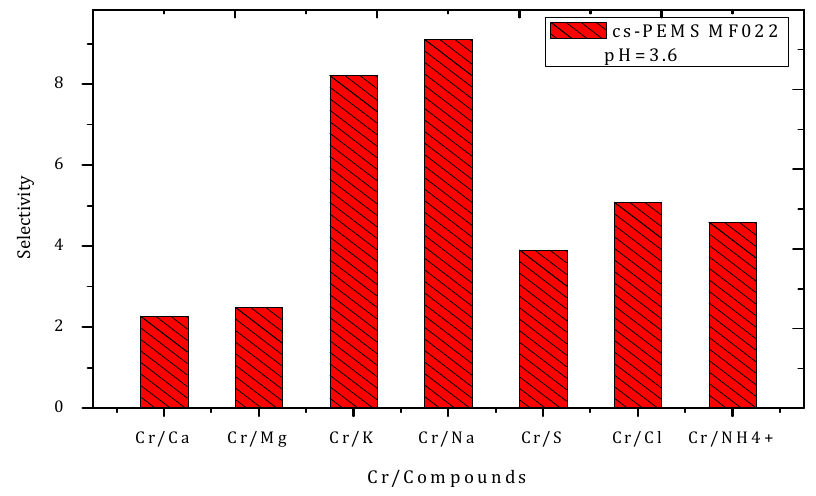
Figure 12. Selectivity of chitosan modified membrane (cs ‐ PES MF022) to chromium relative to the other elements obtained during filtration of synthetic tannery wastewaters at pH 3.6.